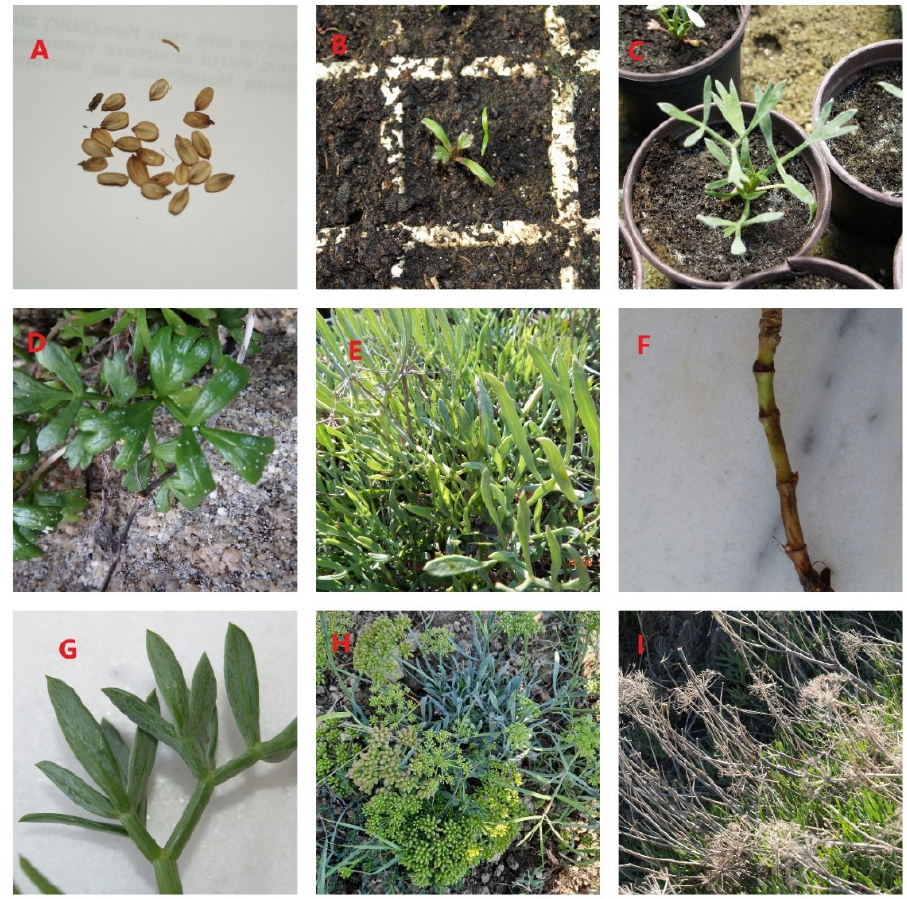
Figure 1. Plant parts of sea fennel: ( A ). Seeds; ( B ). Seedling in seeding tray at the stage of two true leaves; ( C ). Seedling transplanted in pot filled with peat; ( D ). Young leaves of wild plants; ( E ). Aerial parts of fully grown wild plants; ( F ). Stem of fully grown plant; ( G ). Mature leaves; ( H ). Immature inflorescences (umbels); ( I ). Inflorescences after seed maturation and